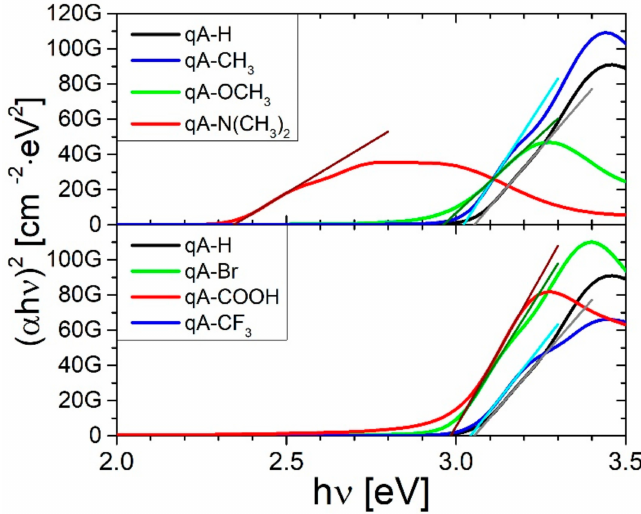
Figure 5. The Tauc plots of the quinoline azo-dye polymers with various electron donating and electron withdrawing